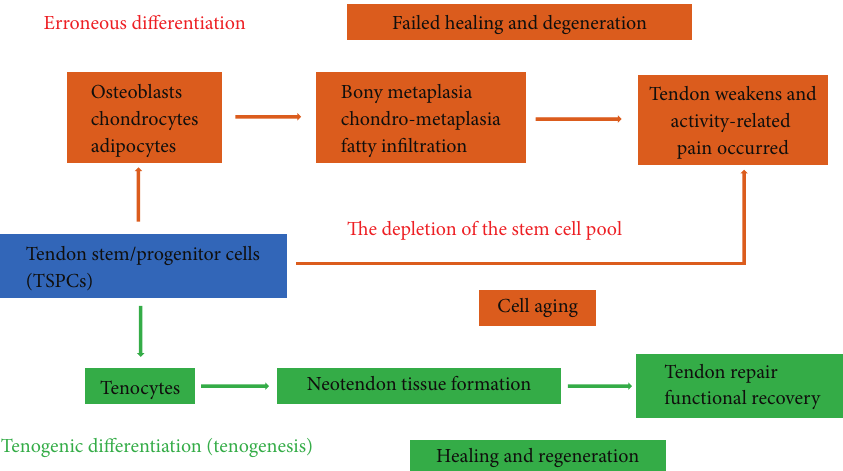
Figure 1: Hypothetical model of altered fate of tendon stem/progenitor cells (TSPCs) in tendinopathy and